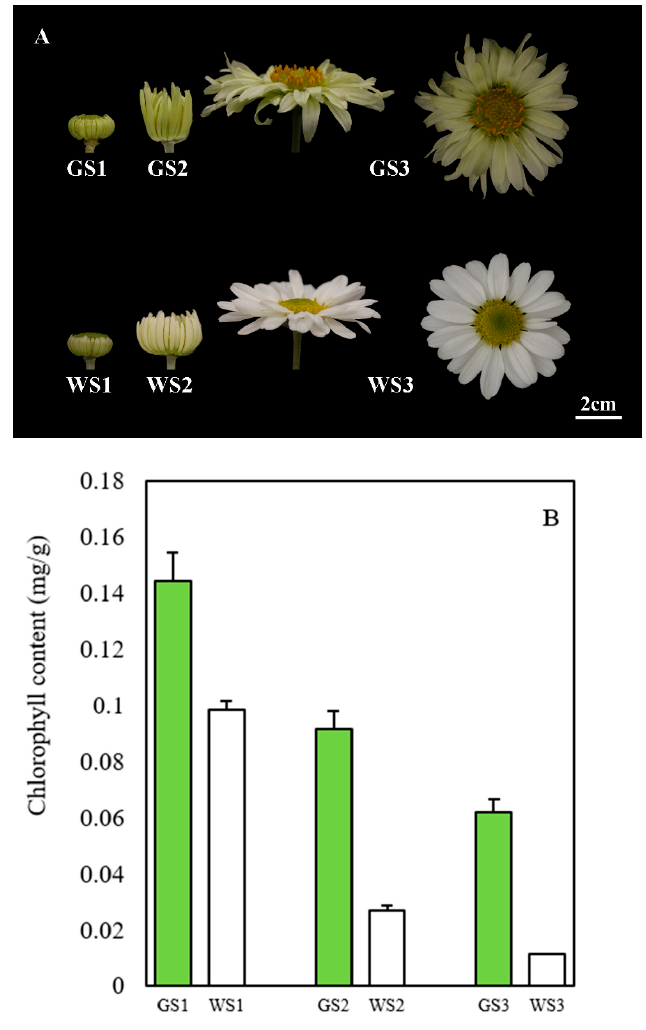
Figure 1. Phenotype and chlorophyll accumulation at three stages of flower development. ( A ) Floret color at each stage of flower development. ( B ) Chlorophyll content of petals from green and white pools at each stage.